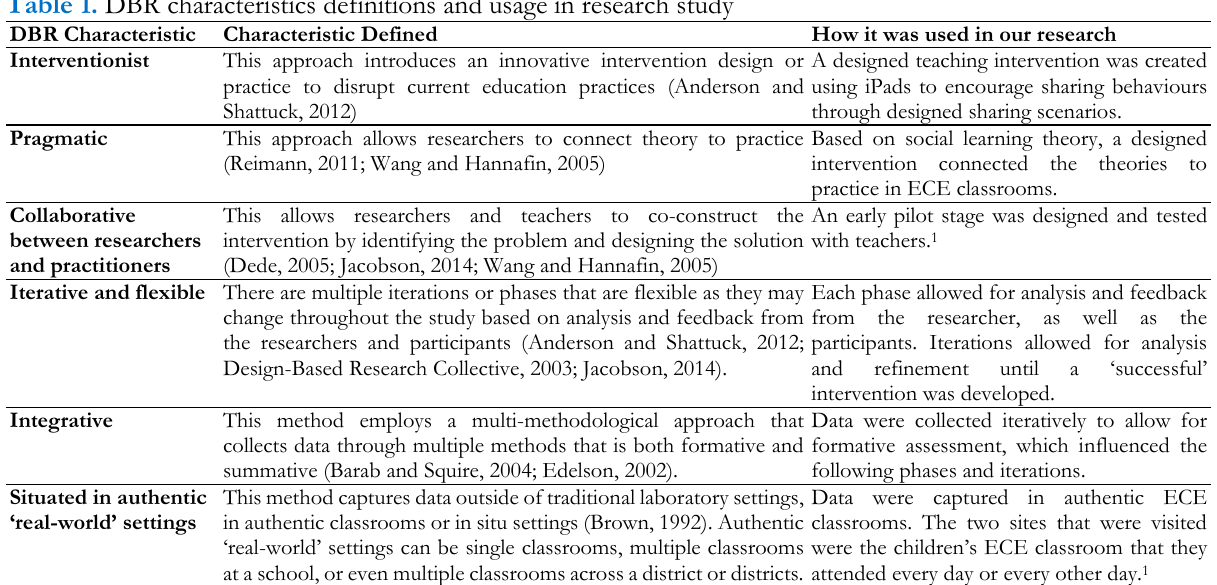
Table 1. DBR characteristics definitions and usage in research study DBR